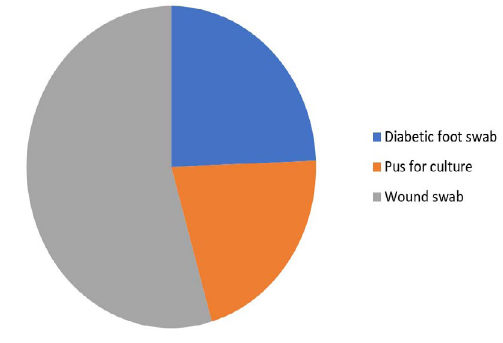
Fig. 1. Female and male distribution for diabetic foot swab patients Table 1. Characteristics of the study population A- Gender distributions (males and females) Type of culture